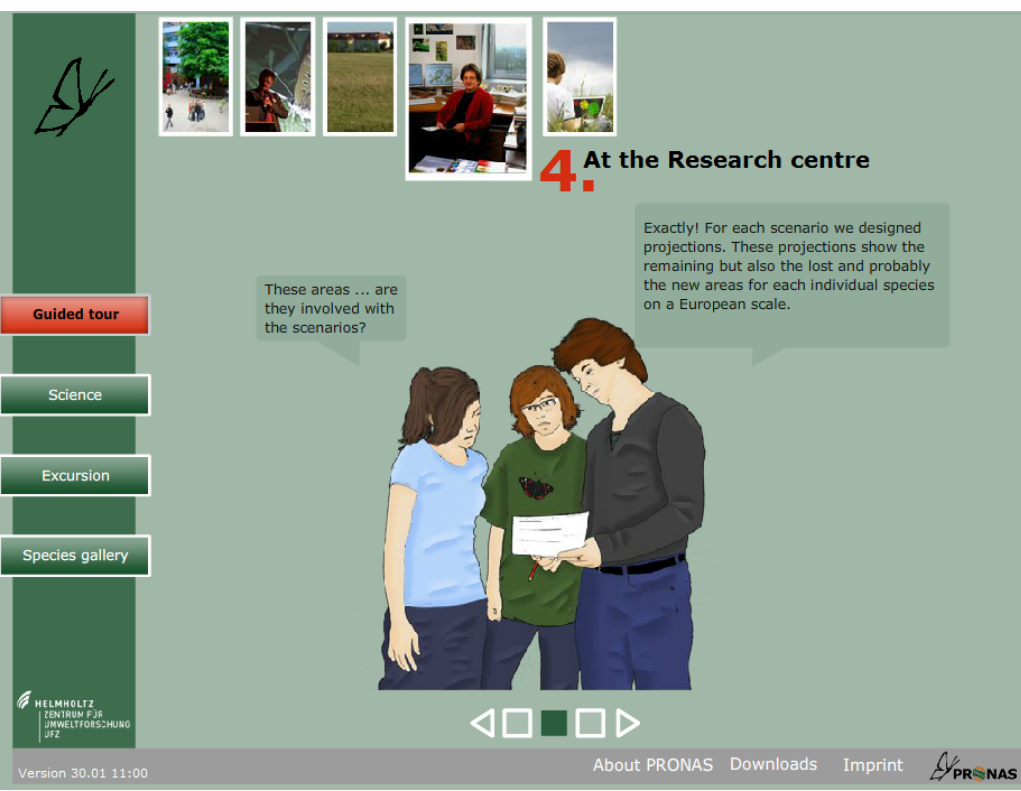
Figure 2. Guided tour of PRONAS: Tom and Tina meet a scientist.